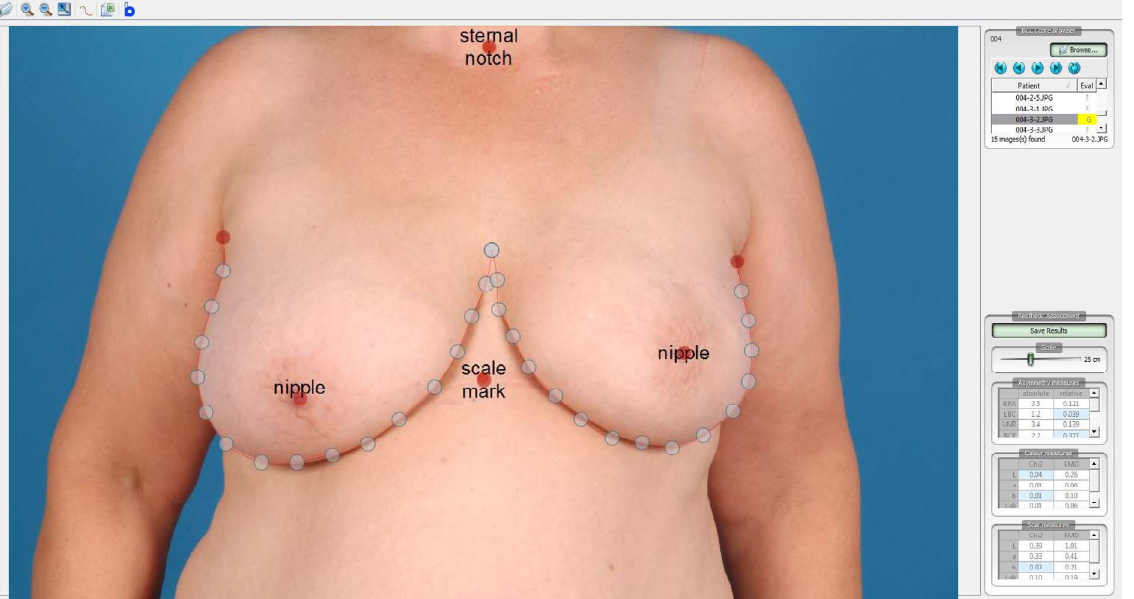
Figure 2. Screenshot of BCCT.core software. The sternal notch, a point 25 cm below, and both nipples are marked. After the user has adjusted the red dots to the most medial and lateral point of the breast outline, the BCCT.core software is able to auto adjust the breast outline and to calculate several asymmetry indices, as well as an overall score (four-point scale: excellent–good–fair–poor).